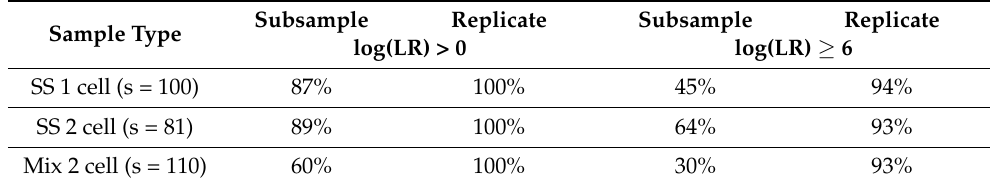
Table 4. Percentage of subsamples and replicates analyzed with EuroForMix that reach the specified